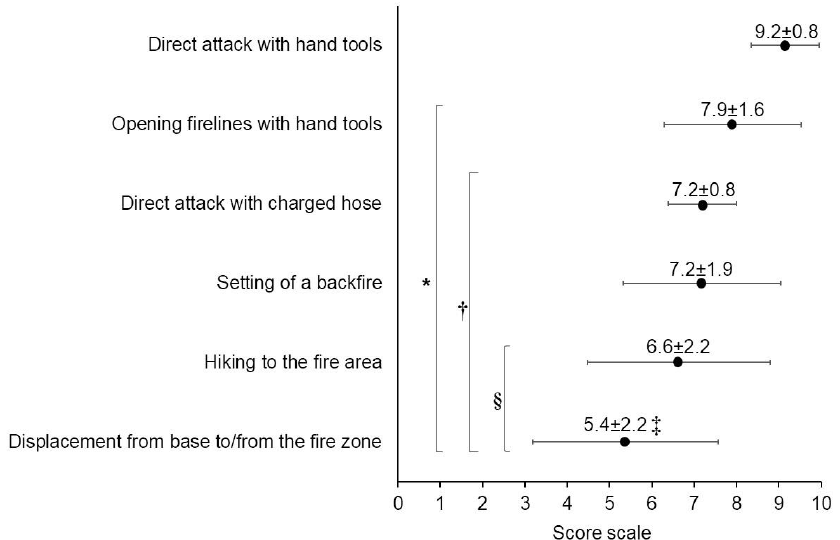
= 11.25; p < 0.05) were judged as more relevant for HM versus WFF (9.3 ± 1.6 vs. 8.9 ± 1.9 and 8.9 ± 1.6 vs. 8.2 ± 2.5, respectively). 3.3. Heat Strain Mitigation Strategies Seventy-one-point-six per cent of those surveyed considered heat acclimatisation an important strategy against heat strain, with an average score of 8.2 ± 1.8. In Italy, firefight- ers assigned a lower score (6.7 ± 2.2) to the need to be acclimatised to the heat (H = 46.52; p < 0.001) compared to the assessment given in the rest of the countries (~8 points). Accli- matisation was assessed significantly lower (H = 12.429, p = 0.029) in the SFF group (7.6 ± 2.2) compared to the WFF (8.2 ± 1.8), WFMM (8.1 ± 1.8) and HM (8.3 ± 2.0). Consistent with the above findings, the statement “ which of the following strategies do you take to acclimatise to the heat and excessive sweating ” obtained an average score of 3.8 ± 3.6. A third of the participants (33.0%) rated this item with 0 points (e.g., never), and only 22% gave this aspect 10 points (e.g., on a regular basis). The overall scores of the implementation of acclimatisation strategies are shown in Figure 2. The best-valued accli- matisation strategies (H = 2168.37; p < 0.001) were training in the heat wearing PPE, and training in sportswear in hot conditions. Different perceptions according to the country (H = 26.006, p < 0.001) and job position (H = 87.457, p < 0.001) were found. In this regard, the implementation of acclimatisation protocols was perceived as less important in Italy (1.9 ± 2.6) than in Spain (4.0 ± 3.9), Argentina (3.9 ± 3.9) and LATAM (4.0 ± 3.9). It was also less relevant for FRO (1.5 ± 2.5) and SFF (2.4 ± 3.0) than for WFF (4.4 ± 3.7), WFMM (4.2 ± 3.5) and HM (4.0 ± 3.3).